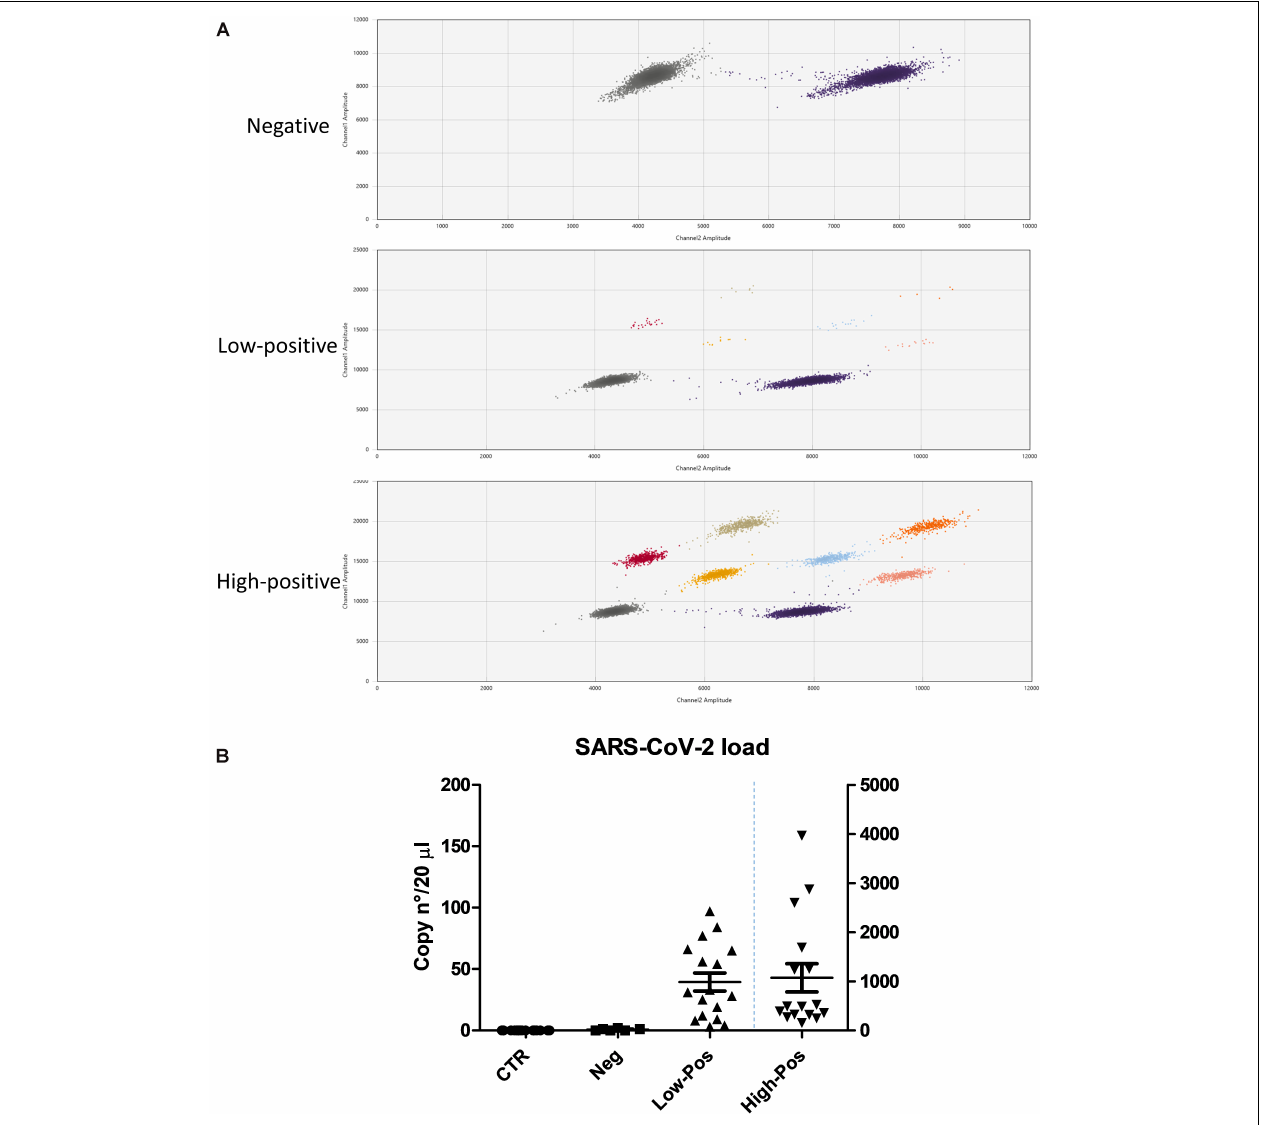
FIGURE 1 | SARS-CoV-2 load in control and COVID-19 subjects, as measured by ddPCR. (A) Graphical representation of the values detected by the use of three different molecular probes: negative samples, only the clouds corresponding to the housekeeping control genes are detectable (gray and purple clouds); low- and high-positive samples, the clouds corresponding to the virus genes are detectable and counted (positives to individual FAM probes: gray, red, and yellow; positives to individual HEX probes: purple, blue, and pink; double positives to FAM/HEX probes: beige and orange). (B) Virus load, expressed as genome copy number per analyzed sample (20 µ l of extracted nucleic acid); left y axis refers to control, negative and low-positive values, whereas right y axis refers to high-positive COVID-19 subjects. Mean value ± SEM is also